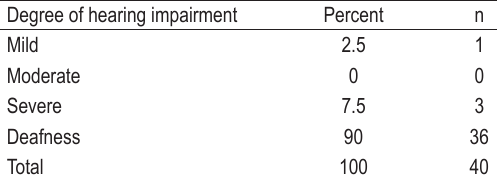
TABLE 8. Degree of hearing impairment